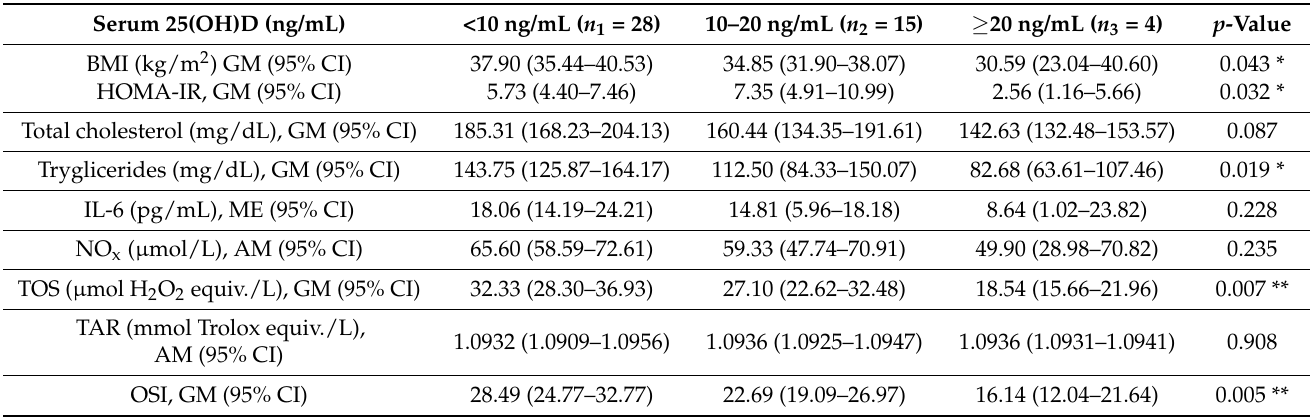
Table 2. Overweight/obesity status, metabolic, pro-inflammatory and oxidative stress biomarkers by categories of serum 25(OH)D.